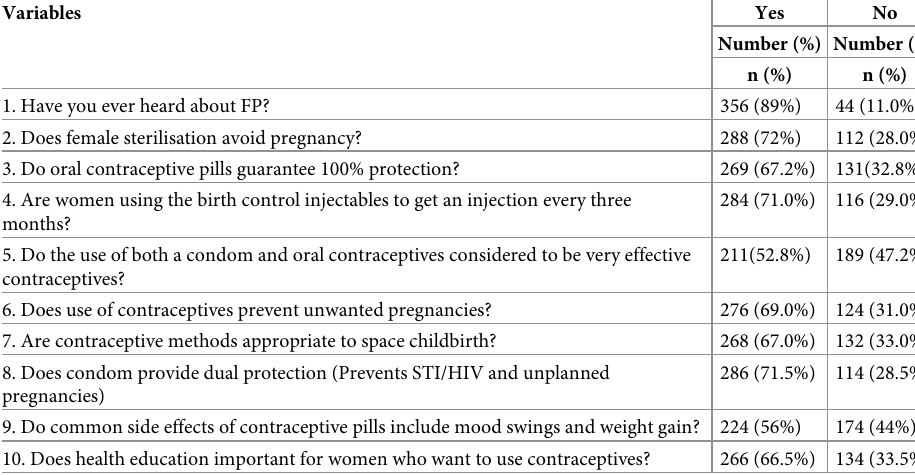
Table 2. Descriptive findings of knowledge related to modern contraceptives among Muslim Women, Banke, Nepal, 2019 (N = 400).